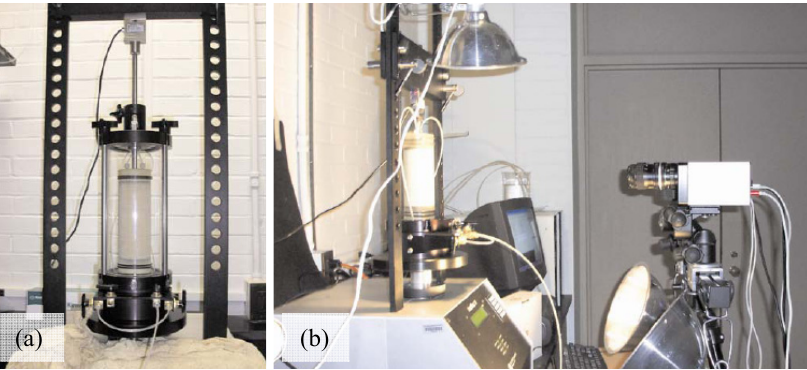
Figure 1. Triaxial system ( a ), and 3 ‐ D imaging system ( b ).